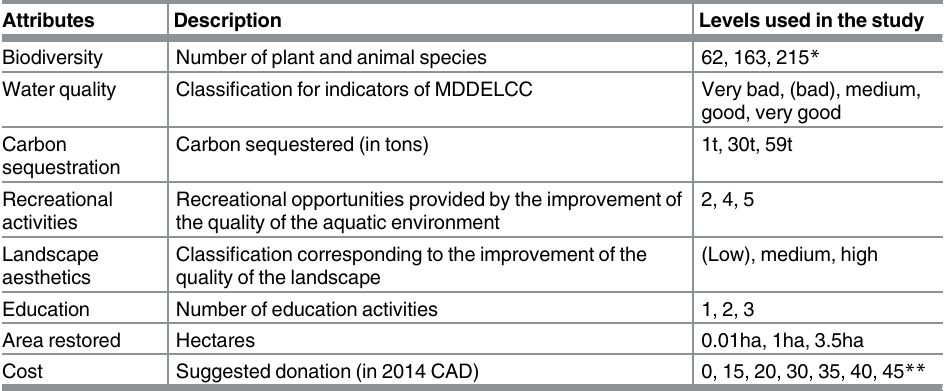
Table 1. Attributes and levels used in the contingent choice